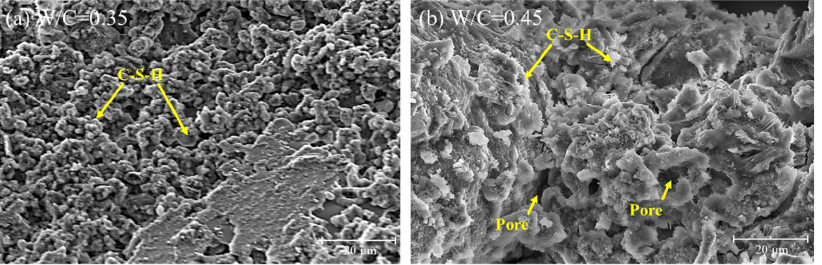
Figure 8. Micromorphology and microstructure of samples with the addition of 1% SAP at 28 d: ( a ) W/C = 0.35 ( b ) W/C = 0.45. ( a ) W/C = 0.35 ( b ) W/C =